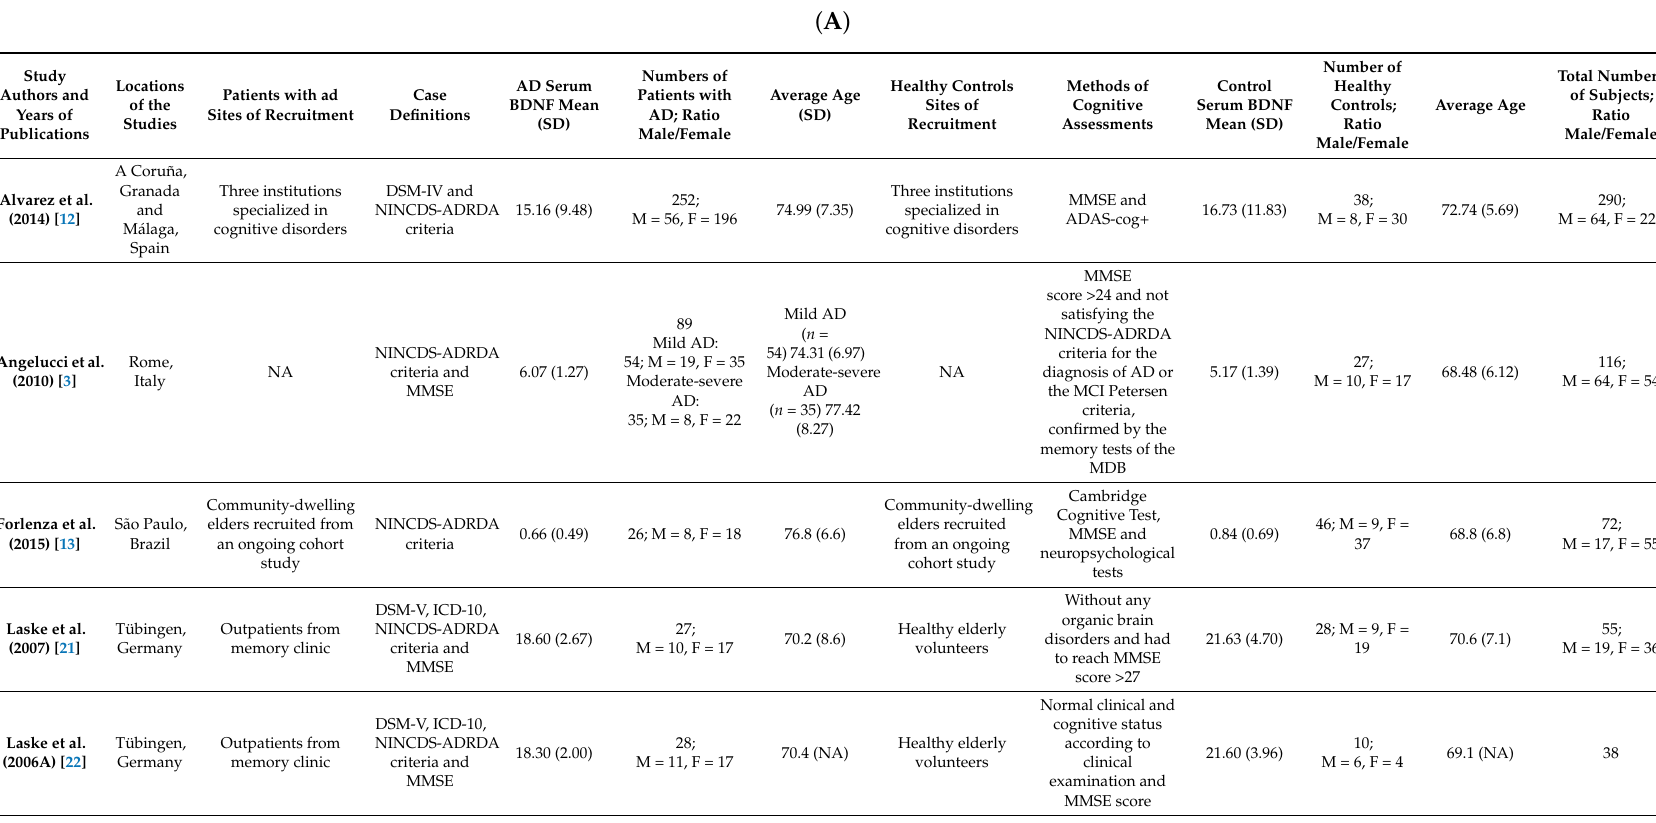
Table 1. ( A ) Serum brain-derived neurotrophic factor (BDNF) levels and study characteristics comparing patients with Alzheimer’s disease (AD) and healthy controls ( n = 2067). MCI: mild cognitive impairment, MMSE: mini-mental state examination; ( B ) Serum BDNF levels and study characteristics comparing patients with AD and individuals with MCI ( n = 906); ( C ) Serum BDNF levels and study characteristics comparing individuals with MCI and healthy controls ( n =